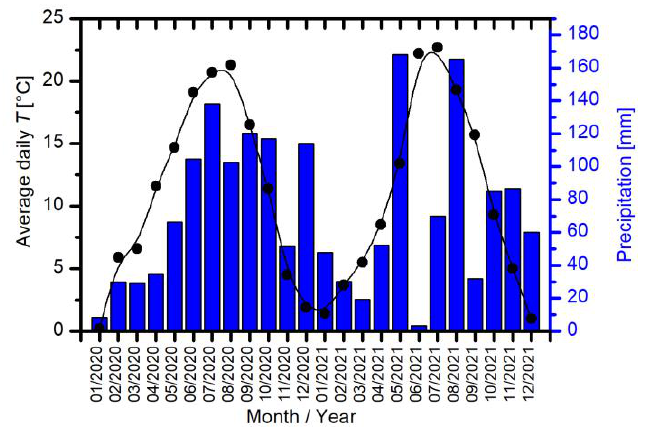
Figure 7. Average daily temperatures and precipitation for each month in years 2020 and 2021 measured on the nearest permanent weather station.